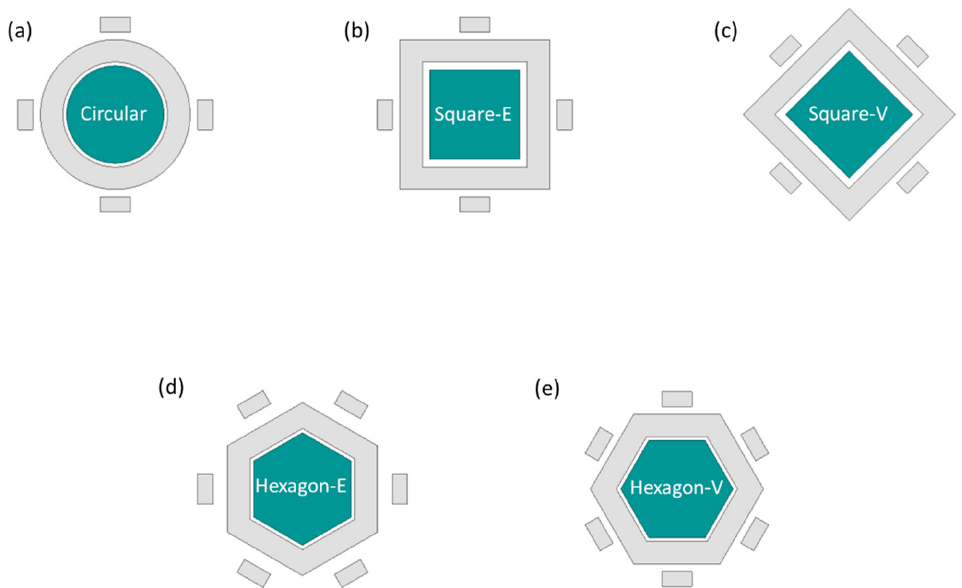
Figure 8. Study of different shapes of an MEMS vibrating wheel on a gimbal gyroscope. ( a ) circular ( b ) square-edge ( c ) square-vertex ( d ) hexagon-edge ( e ) hexagon-vertex.